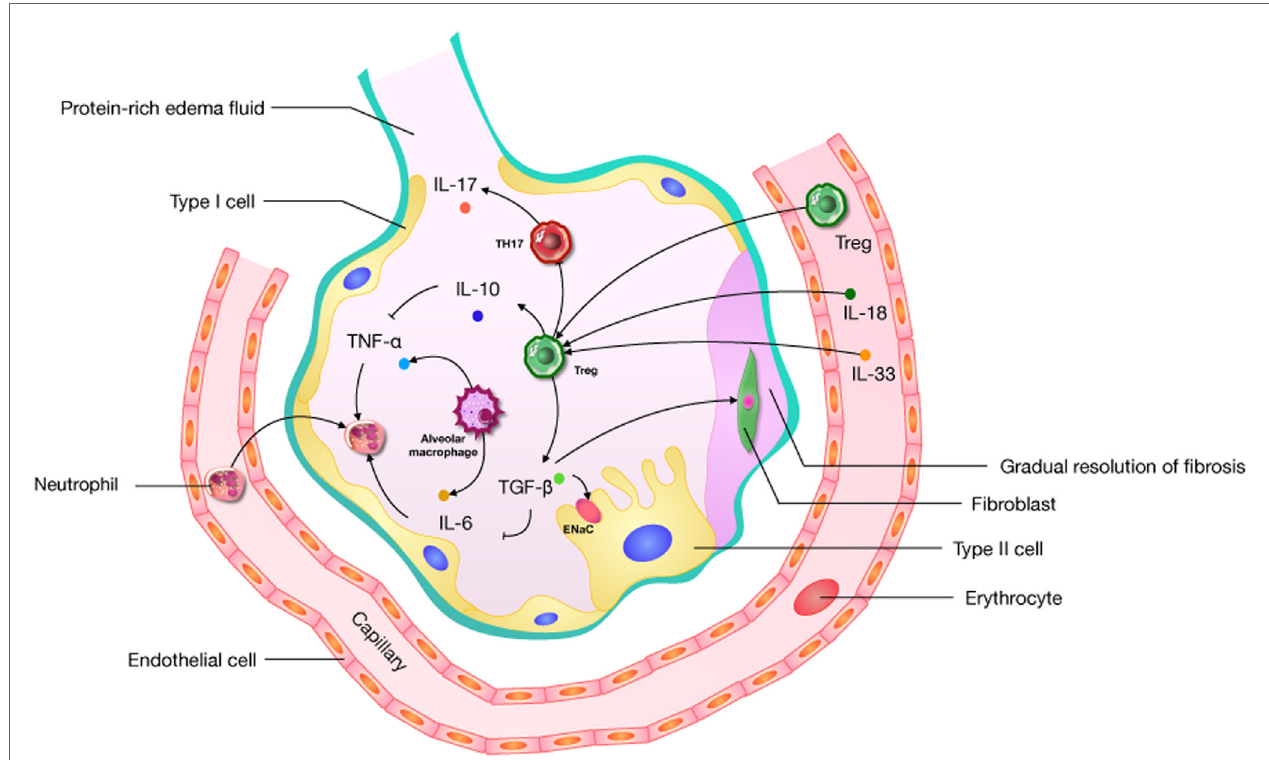
FiGURe 2 | A pathophysiological schematic about regulatory T cells (Tregs) improving the acute lung injury (ALI) process through the influence of cytokines (including TGF- β , IL-6, IL-10, IL-17, IL-18, and IL-33) which has been confirmed. ENaC: epithelial sodium channel; “ → ”: promote; “ ⊥ ”: